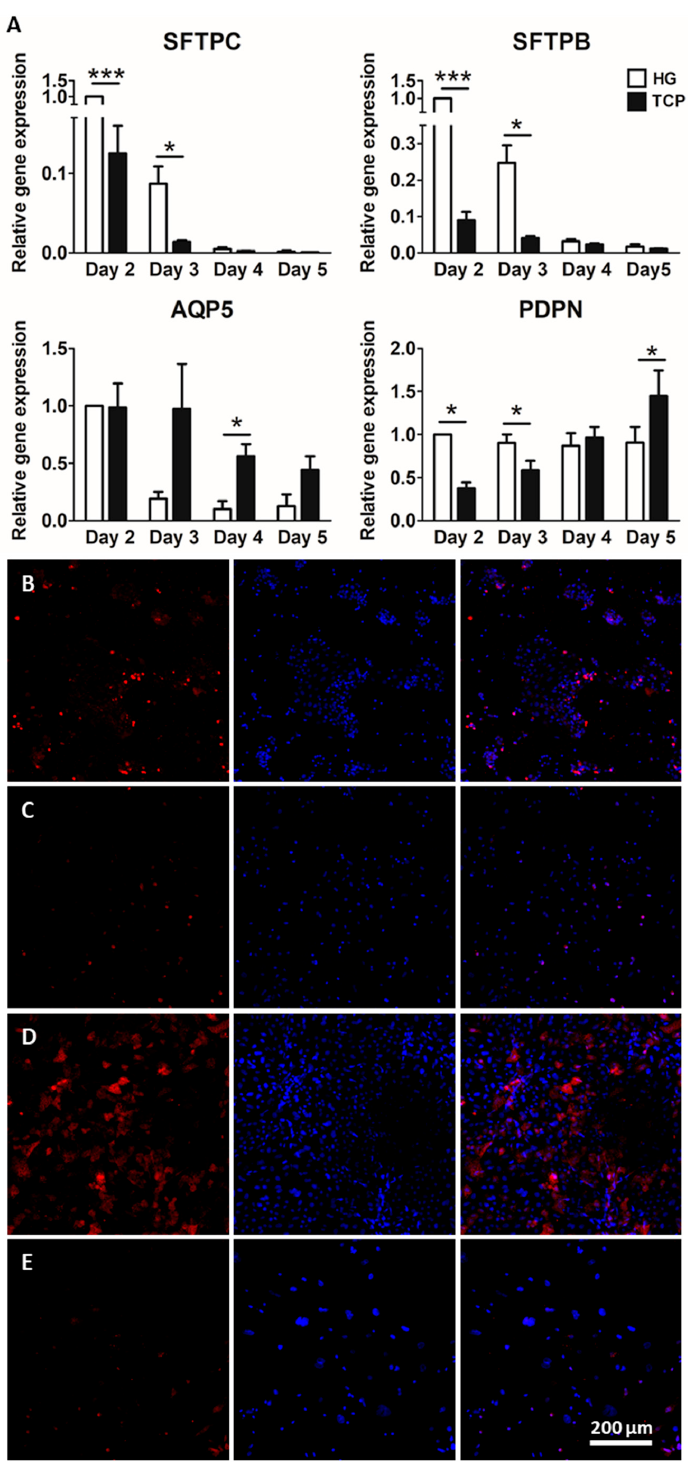
Figure 3. ATII cells were cultured either on hydrogel (HG) or a tissue culture plate (TCP). ATII typical marker surfactant proteins C ( sftpc ) and B ( sftpb ) and ATI typical marker aquaporin 5 ( aqp5 ), podoplanin ( pdpn ) were studied at different time points (from day 2 to day 5) by qPCR ( A ). Relative gene expression is shown. Expression of surfactant protein C (SPC) was studied using immunofluo- rescence on ATII cells cultured on hydrogel at day 2 ( B ) and day 4 ( D ) and on a plate at day 2 ( C ) and day 4 ( E ). * p < 0.05, *** p <